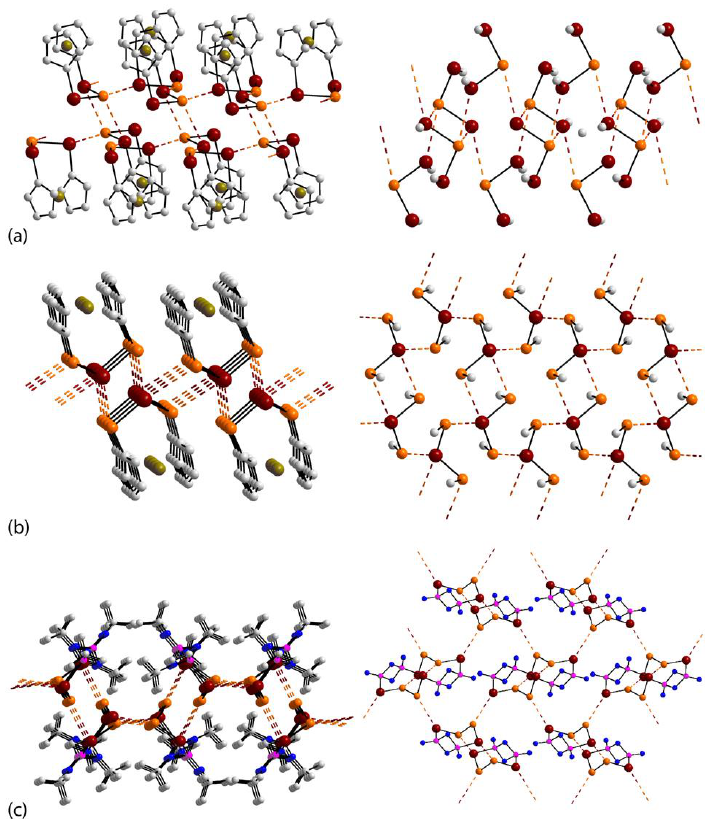
Figure 14. Supramolecular aggregation via Te … Se secondary bonding in (a) 56 {QAZGUV; d(Te … Se) = 3.70, 3.79 & 3.92 Å }, (b) 57 {OMIHAV; 3.62 & 3.69 Å }, and (c) 58 {ONEGIZ; 3.82 & 3.89 Å }. In the 3.70, 3.79 & 3.92 Å}, ( b ) 57 {OMIHAV; 3.62 & 3.69 Å}, and ( c ) 58 {ONEGIZ; 3.82 & 3.89 Å}. In the simplified views of ( a ) and ( b ), only the carbon atom bound to selenium / tellurium are shown, and in ( c ), the t-butyl groups are